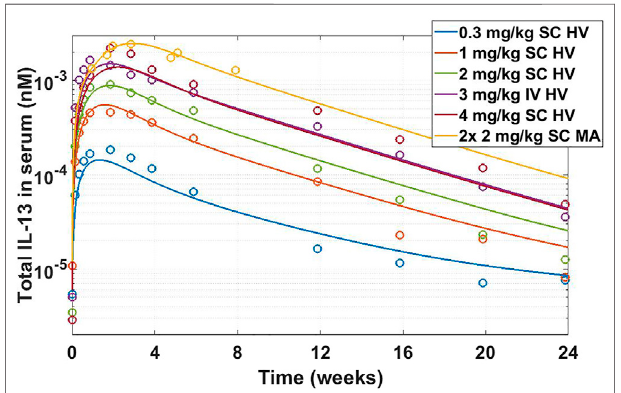
FIGURE 8 | Total IL-13 accumulation after IMA-026 administration in Phase I trial - model simulations vs published data. Different color solid lines correspond to different doses, open circles with corresponding colors are clinical data. Labels: SC, subcutaneous; IV, intravenous; HV, healthy volunteers;MA,mildasthmatics.Themodelreasonably capturesthebehavior using internal af fi nity measures, previously published target data, and published PK parameters for IMA-026, without fi tting any parameters.